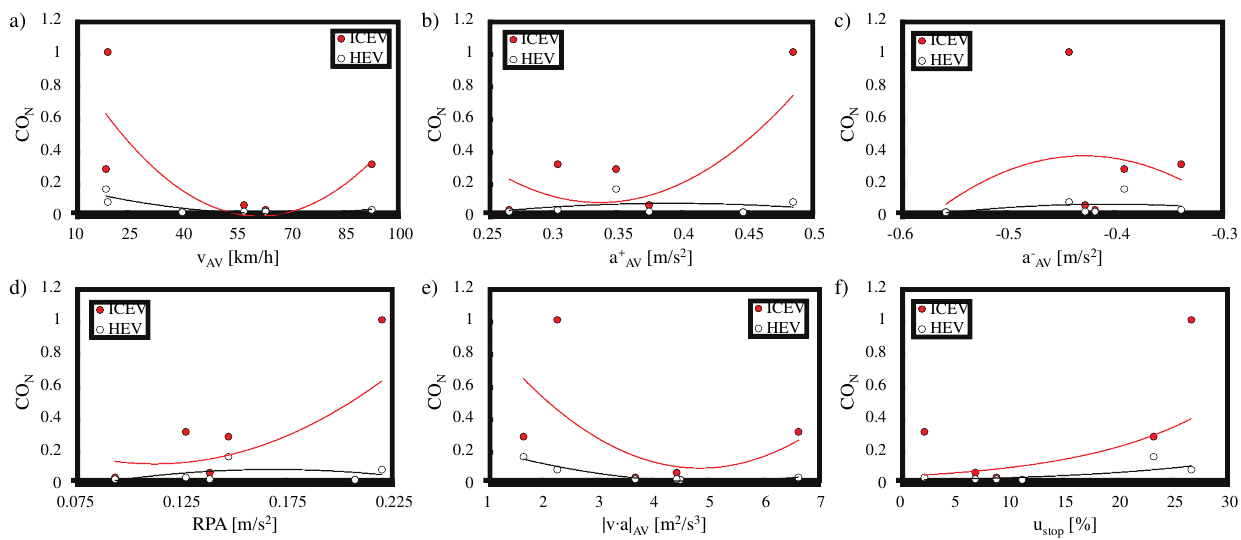
Fig. 4. The dependence of normalized road emission of carbon monoxide on driving pattern parameters: average speed (a), average acceleration (b), average deceleration (c), relative positive acceleration (d), average absolute value of the product of speed and acceleration (e), time share of vehicle stop